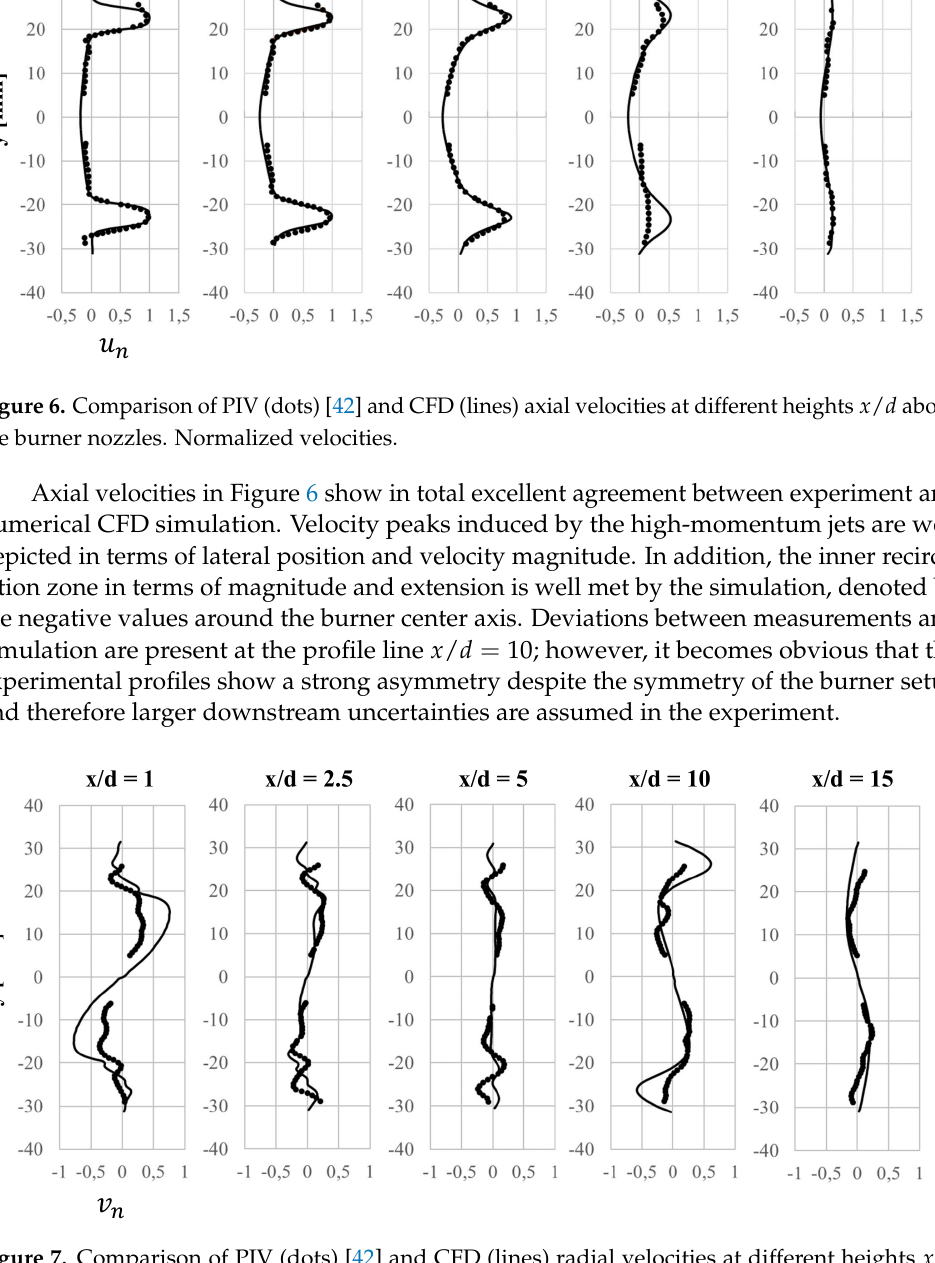
Figure 7. Comparison of PIV (dots) [42] and CFD (lines) radial velocities at different heights x / d above the burner nozzles. Normalized velocities, scaled by factor